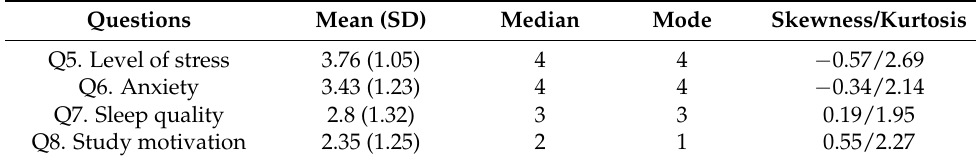
Table 2. Descriptive analysis of responses to psychological impact items.